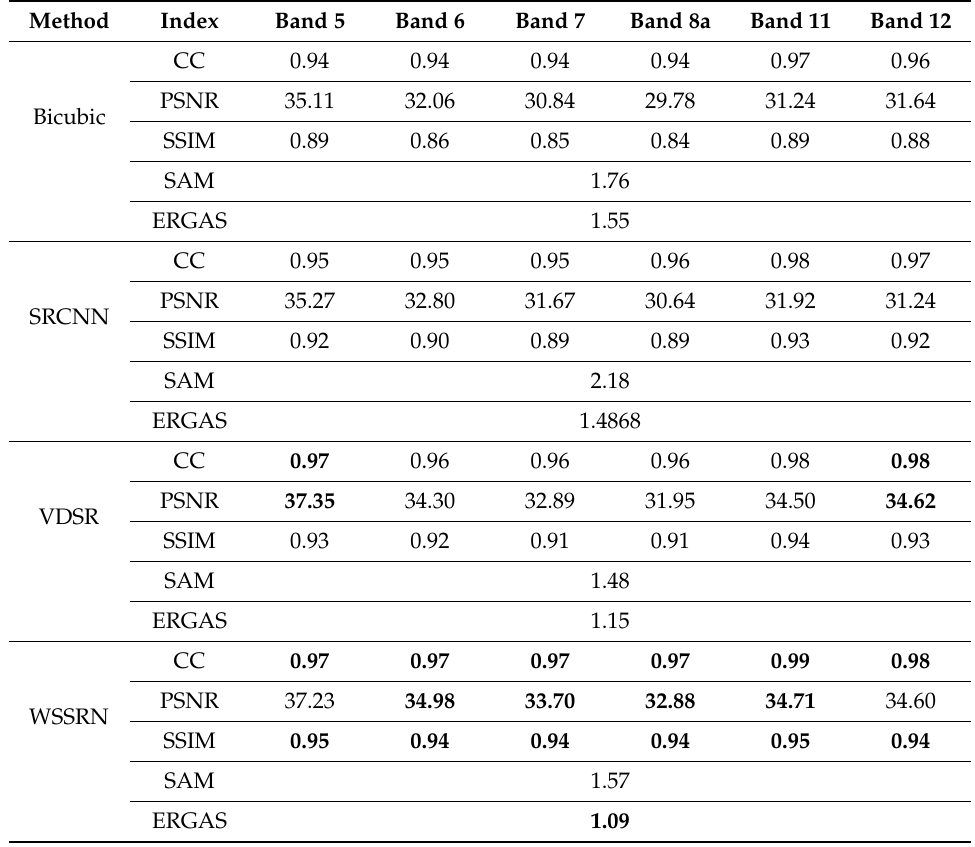
Table 3. Quantitative evaluation for the simulated